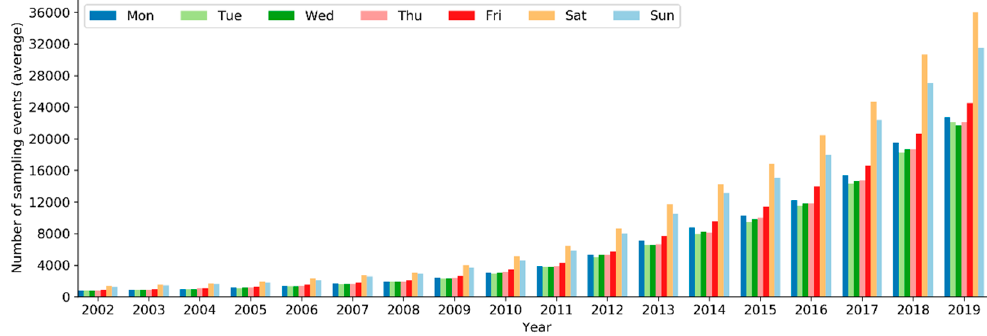
Figure 7. Average number of sampling events on each day of the week over the years.